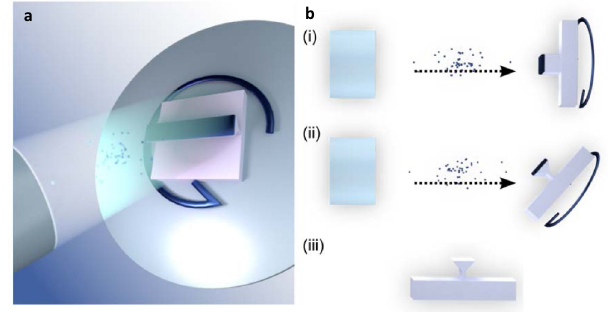
Fig. 5 Reactive ion beam etching (RIBAE). a Graphical depiction of RIBAE. b RIBAE fabrication steps (i) Top-down etching of a diamond sample mounted perpendicular to the ion beam path on a rotating sample stage. (ii) Sample is tilted to obtain an acute angle between the sample and ion beam, uniformly etching underneath the etch mask. (iii) Mask removal yields undercut nanostructures from a bulk